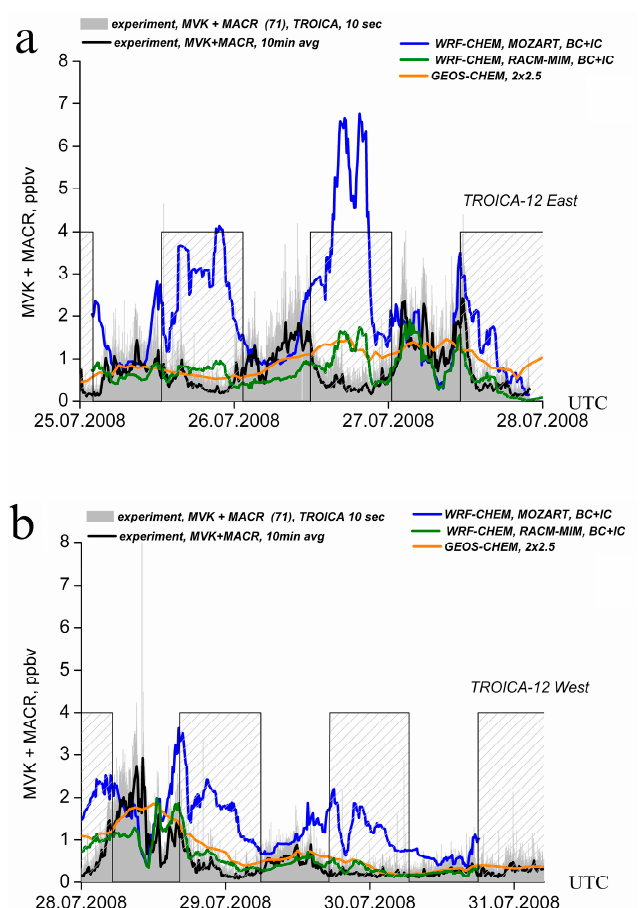
Figure 5. The comparison of the 10-sec initial experimental MVK+MACR data (light grey areas) and the 10-min averaged data (grey lines) from TROICA-12 East ( a ) and West ( b ) measurements, with the simulations of the regional WRF-CHEM model with the RACM-MIM and MOZART gas-phase mechanism and the global GEOS-CHEM model. The shaded rectangles correspond to night-time measurements (21:00–09:00 LT).